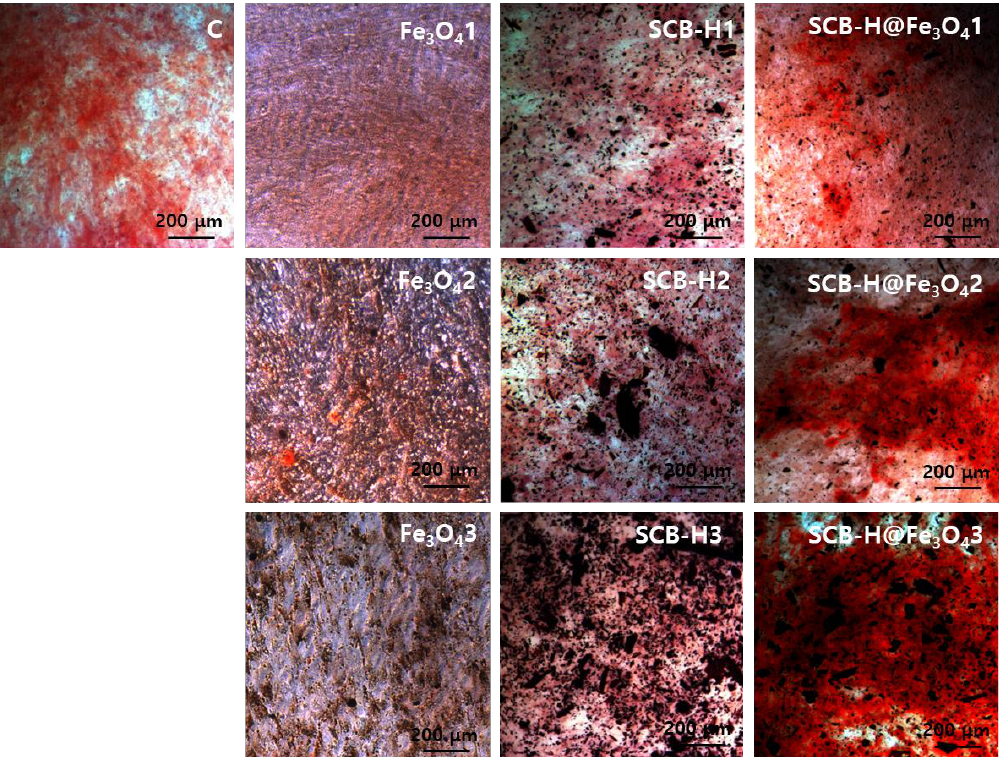
Figure 4. Analysis of calcium deposition by ARS staining. hADMSCs were differentiated to osteoblasts for 14 days in osteogenic induction media with or without nano-scaffolds. After differentiation, the calcium deposition was determined with ARS staining. Intracellular and extracellular calcium was stained to red by ARS. C: vehicle, 1: 25 µ g / mL, 2: 50 µ g / mL 3: 100 µ g /